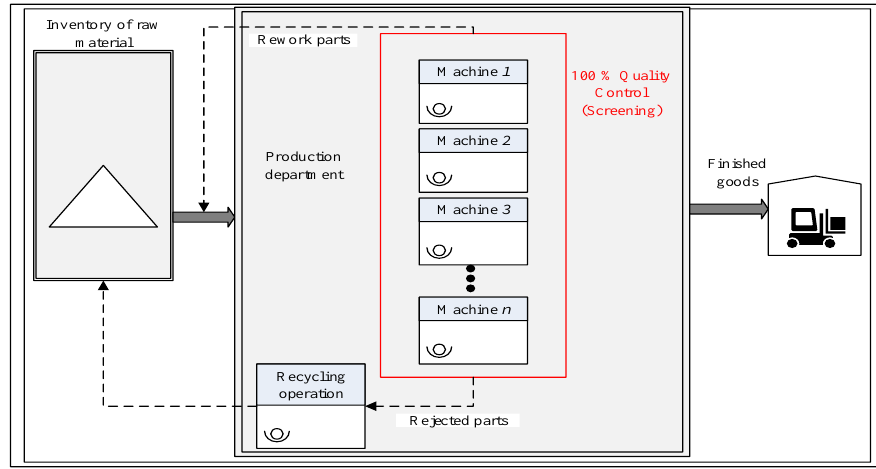
Figure 1. Representation of imperfect quality production